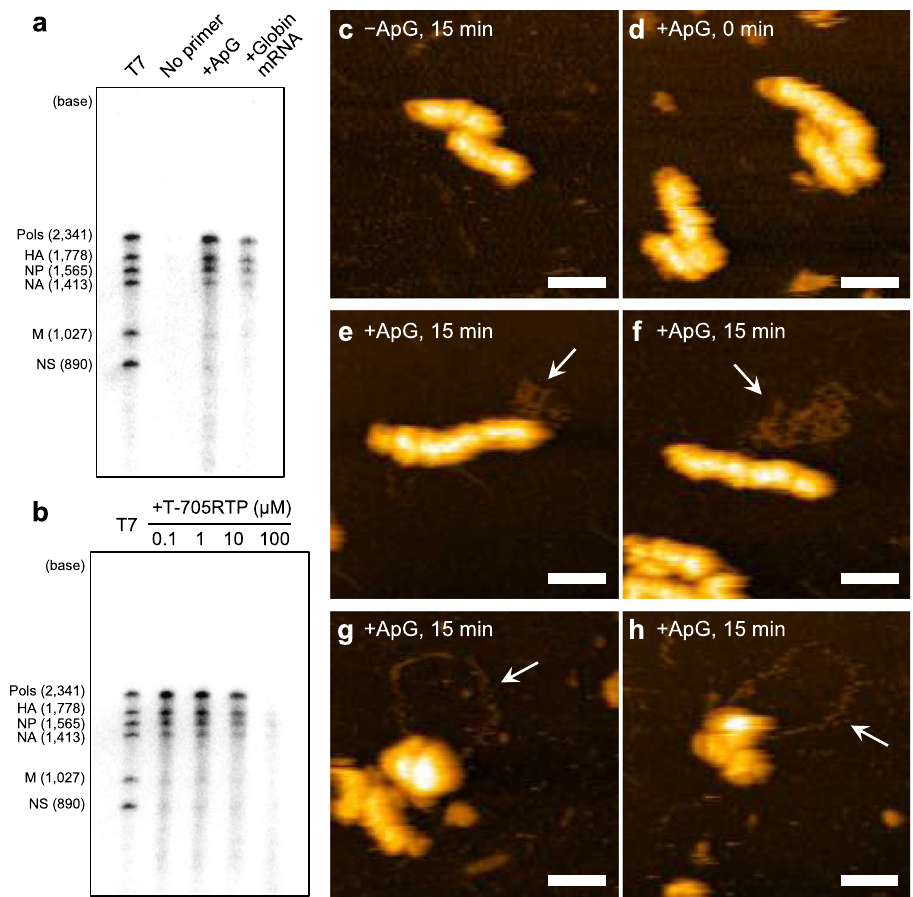
Fig. 1 HS-AFM observation of vRNPs during RNA synthesis. a Primer-dependent in vitro RNA synthesis using virion-derived vRNPs. RNA was synthesized in vitro using ApG or globin mRNA as a primer with 30 min incubation. As a negative control, the reaction mixture was used without primer. A mixture of eight in fl uenza A virus vRNA segments (Pols indicates 3 polymerases, PB2, PB1, and PA) transcribed by T7 RNA polymerase was loaded in the leftmost lane (T7) for evaluation of sizes of the newly synthesized RNAs. b Inhibition of in vitro RNA synthesis by T-705RTP. RNA was synthesized in vitro using ApG in the presence of the indicated concentration of T-705RTP. All puri fi ed RNA samples were analysed on a 4% polyacrylamide gel containing 7 M urea and detected by autoradiography. Uncropped autoradiograph images are shown in Supplementary Fig. 9. c As a negative control for the HS-AFM observation, the reaction mixture omitting a primer was used. d – h Virion-derived vRNPs were subjected to in vitro RNA synthesis using ApG as a primer. After incubation for 0 min ( d ) or 15 min ( c, e – h ), samples were observed with HS-AFM. Folded and looped RNAs associated with the helical ( e, f ) and deformed vRNPs ( g, h ), respectively, were observed as indicated by arrows at the different positions in the same samples. Scale bars on all images represent 50